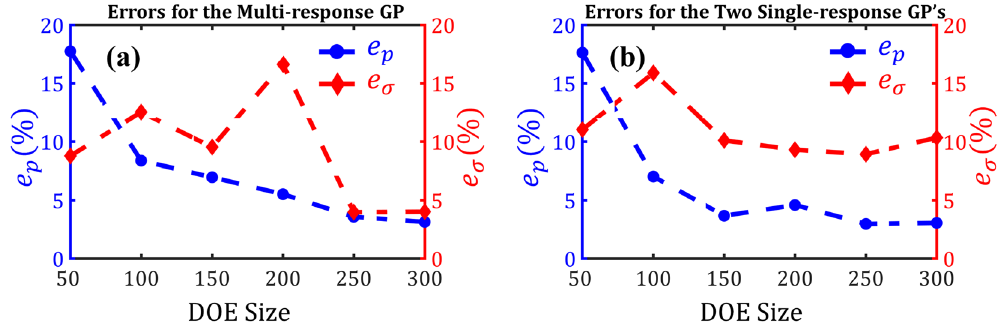
Figure 3. Reduction of prediction error (in percent) by increasing the number of training samples: ( a ) Prediction errors for the MRGP model. ( b ) Prediction errors for the SRGP models. The errors are all calculated based on 100 test points that were not used in